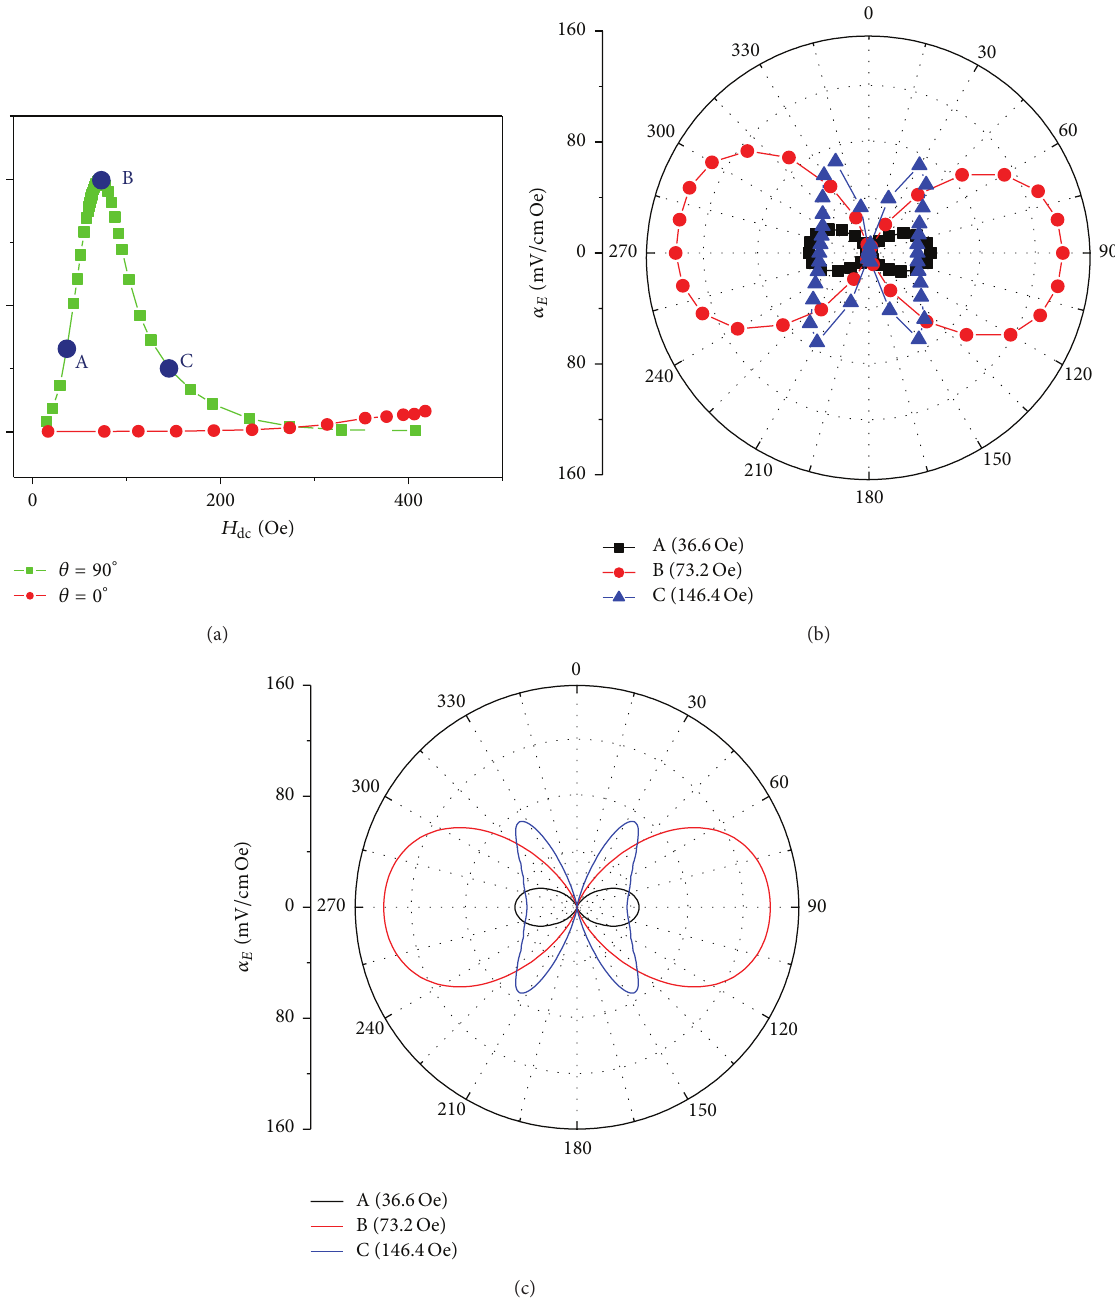
Figure 2: (a) Magnetic-field dependence of ME coefficient 𝛼 𝐸 in the FeBSiC/PZT/FeBSiC trilayer with a dimension of 10 × 10 × 0.5 mm 3